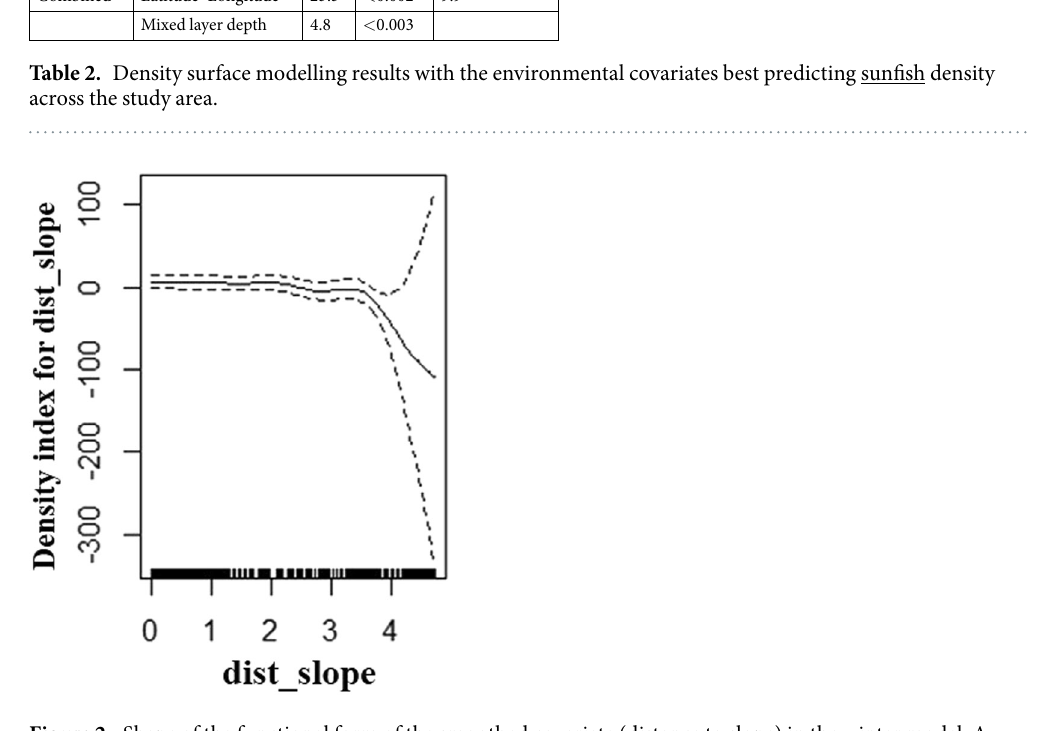
Figure 2. Shape of the functional form of the smoothed covariate (distance to slope) in the winter model. A zero on the Y axis corresponds to no effect of the covariate on the response variable (individual sightings). The dashed lines represent twice the standard error of the estimated curves (95% confidence bands). The locations of the observations are plotted as small ticks along the X axis. Figure generated using R version 3.3.1 https://